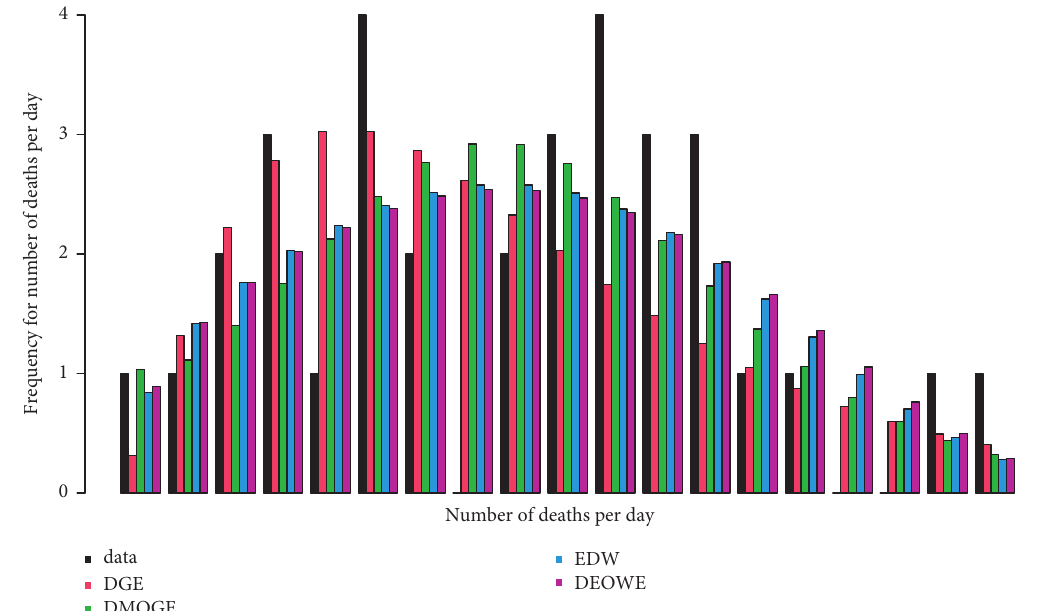
Figure 13: Graphical plots for the expected frequencies and the data using the PMF of different parameters’ distributions, where the x -axis represents the number of deaths per day and the y -axis represents the frequency for this